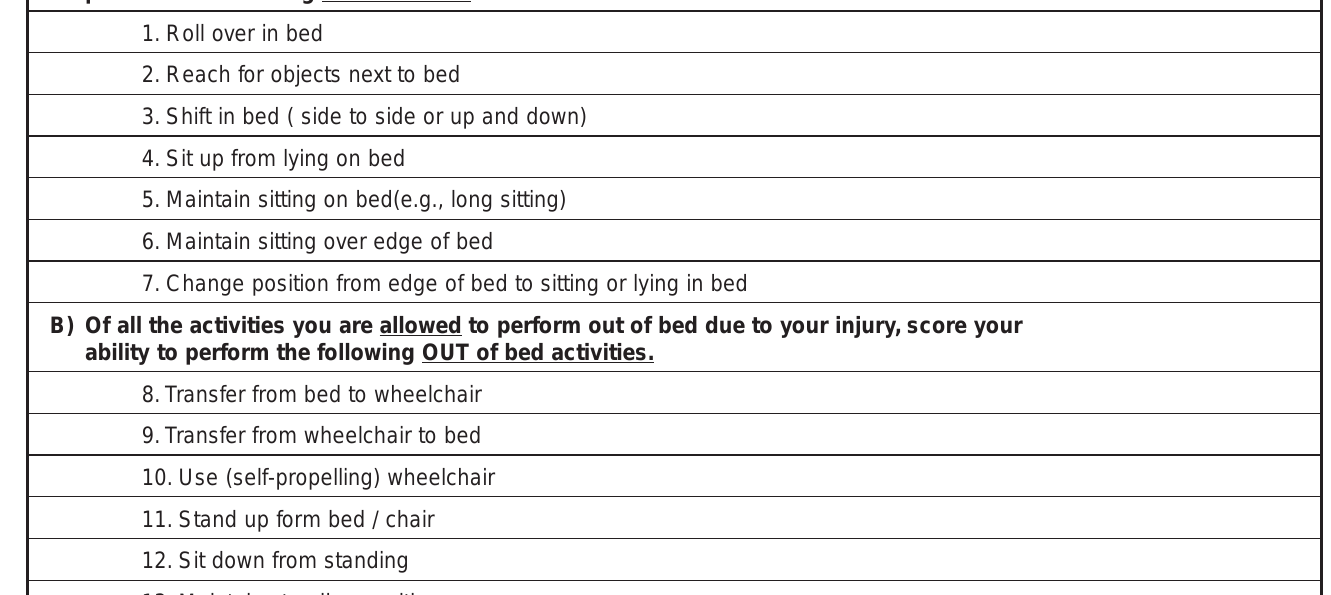
Table 3: Draft functional items for trauma inpatient outcome measure A) Of all the activities you are allowed to perform due to your injury, score your ability to perform the following bed